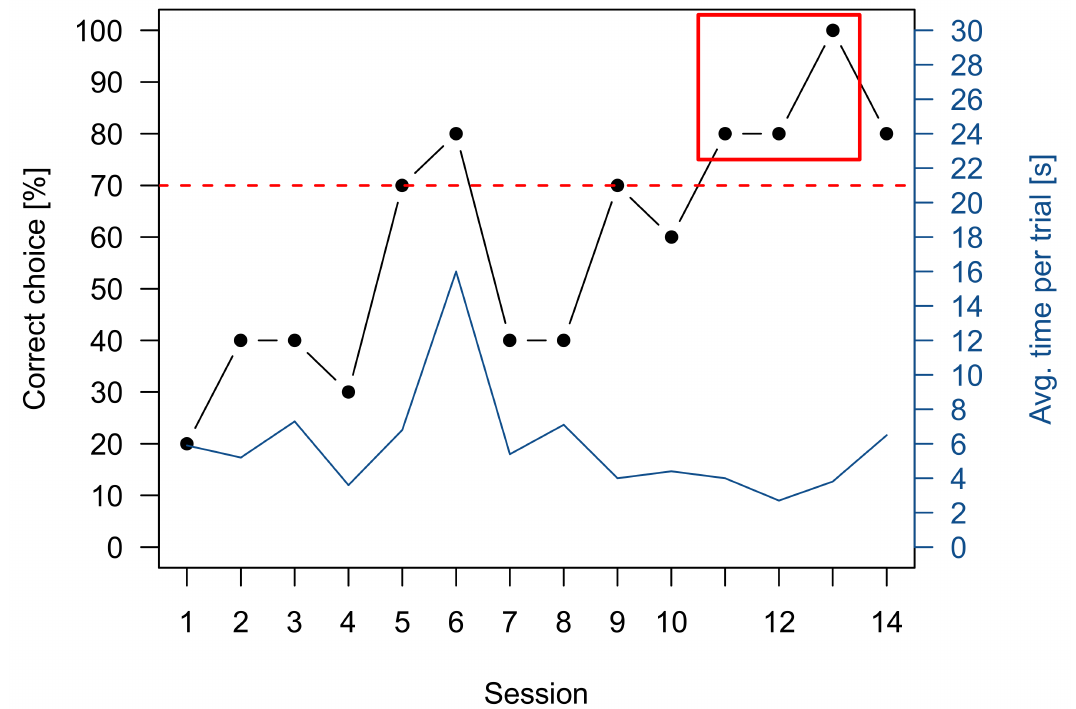
Figure 4. Exemplary learning curve of a shark during Pretraining. The black dots show the percentage of correct choices per ten-trial session. The red dotted line indicates the lower limit of the LC while the red square highlights the section in which the LC was achieved. The blue line gives the average trial time for each